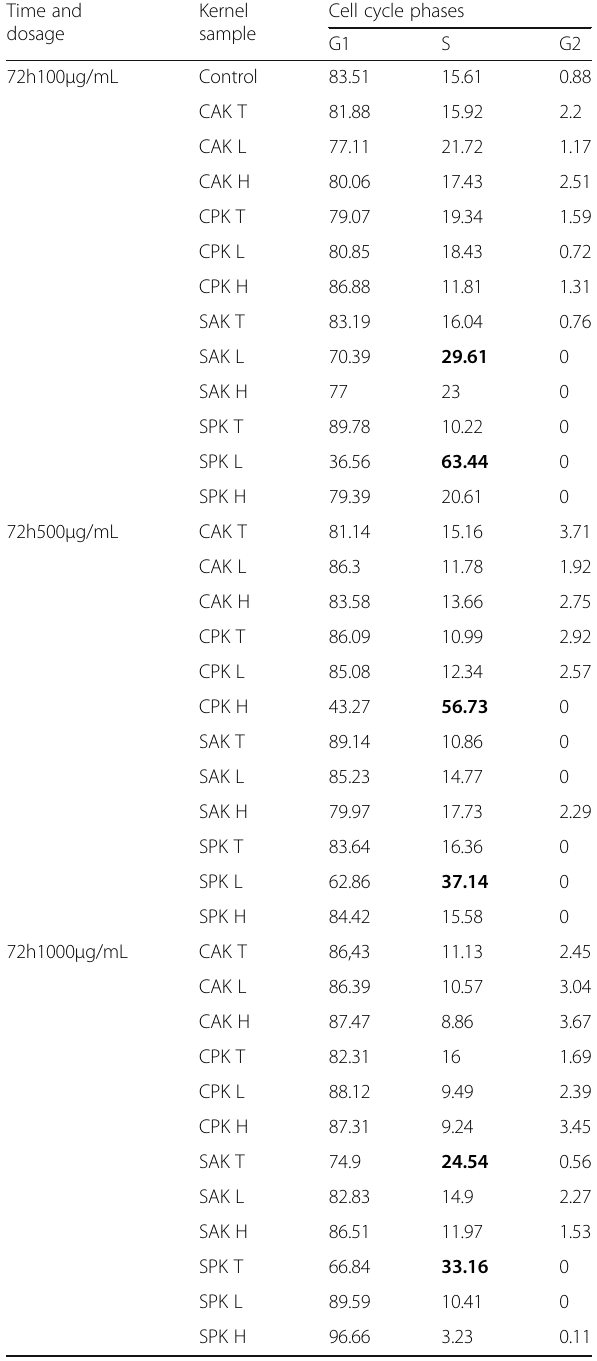
Table 3 The percentage distribution of the control and CAK, CPK, SAK and SPK treated HT-29 cells after 72 h. Although the SAK and SPK extracts induced an outspoken increase in percentage of cells that arrested in the S-phase, for most of the extractions the effect was